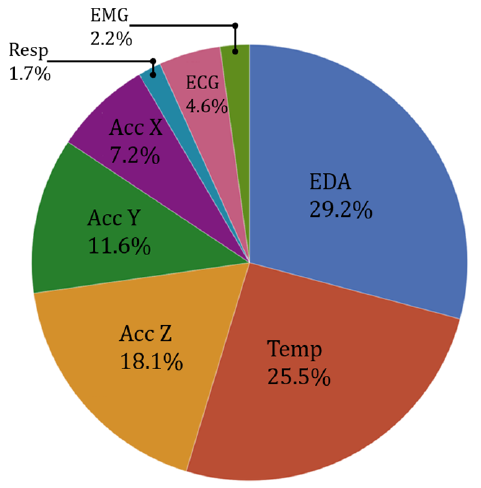
Figure 3. Significance of the features based on how frequently they were used in three different classifiers for best accuracies. EDA, temperature, and accelerometer Z (and Y) stand out as the important features.